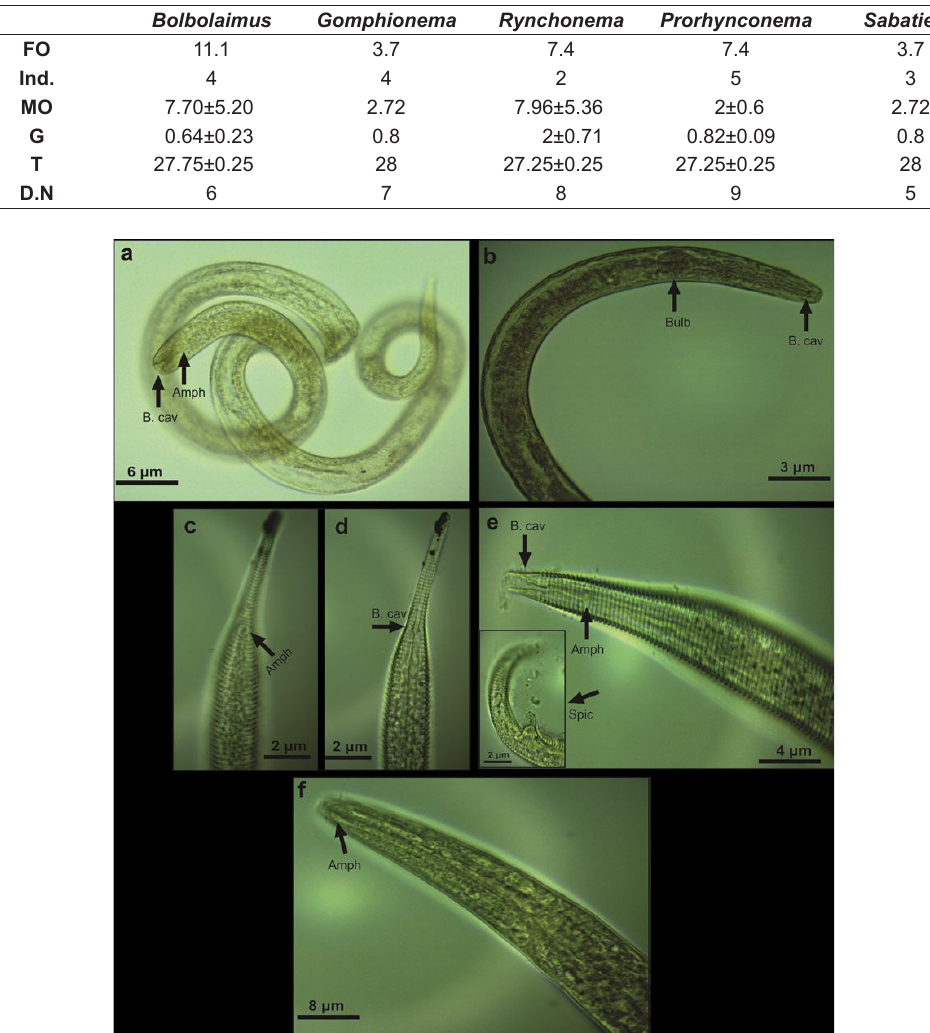
Table 1. Free-living Nematoda genera reported in this study, their frequency of occurrence (FO; %), number of individuals sampled (Ind.) and environmental parameters of the samples containing them. MO = organic matter content (%); G = granulometry (mm); T = temperature (°C). Environmental parameters are presented as mean ± standard deviation whenever appropriate; D.N= deposit number.